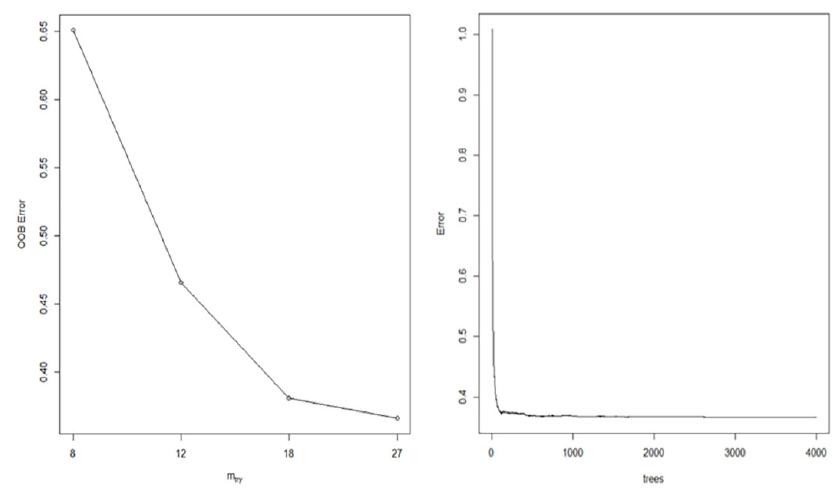
Figure 3. Random Forest. Hyperparameters and OOB error diagram.